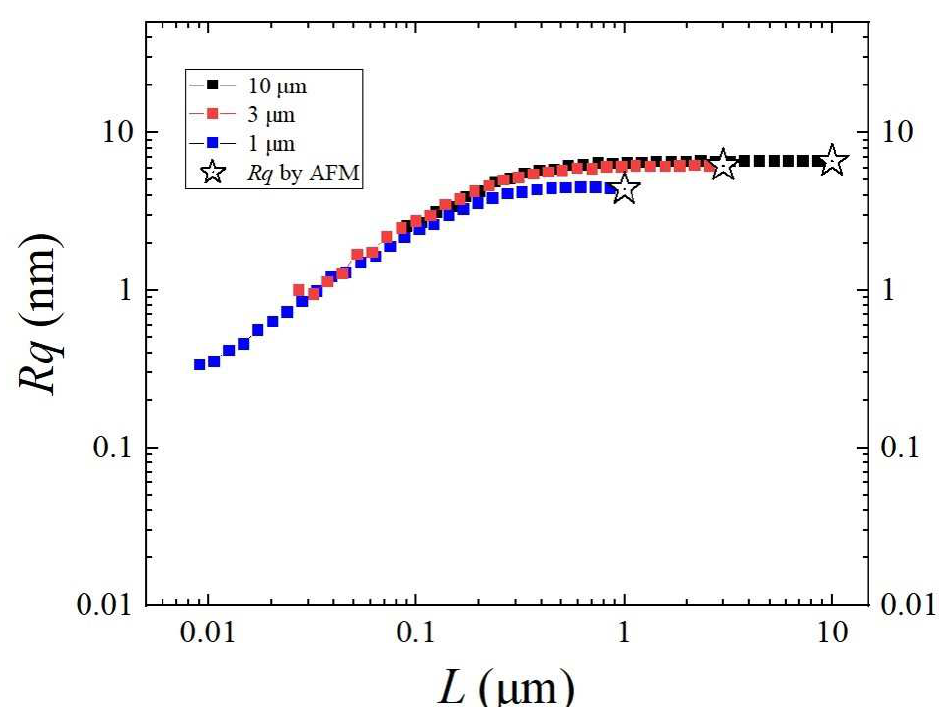
Figure 12. Rq values obtained by actual AFM measurements at L of 1, 3 and 10 µ m (denoted with star symbols) and Rq - L curves obtained with RSE-f0 method (denoted with squared